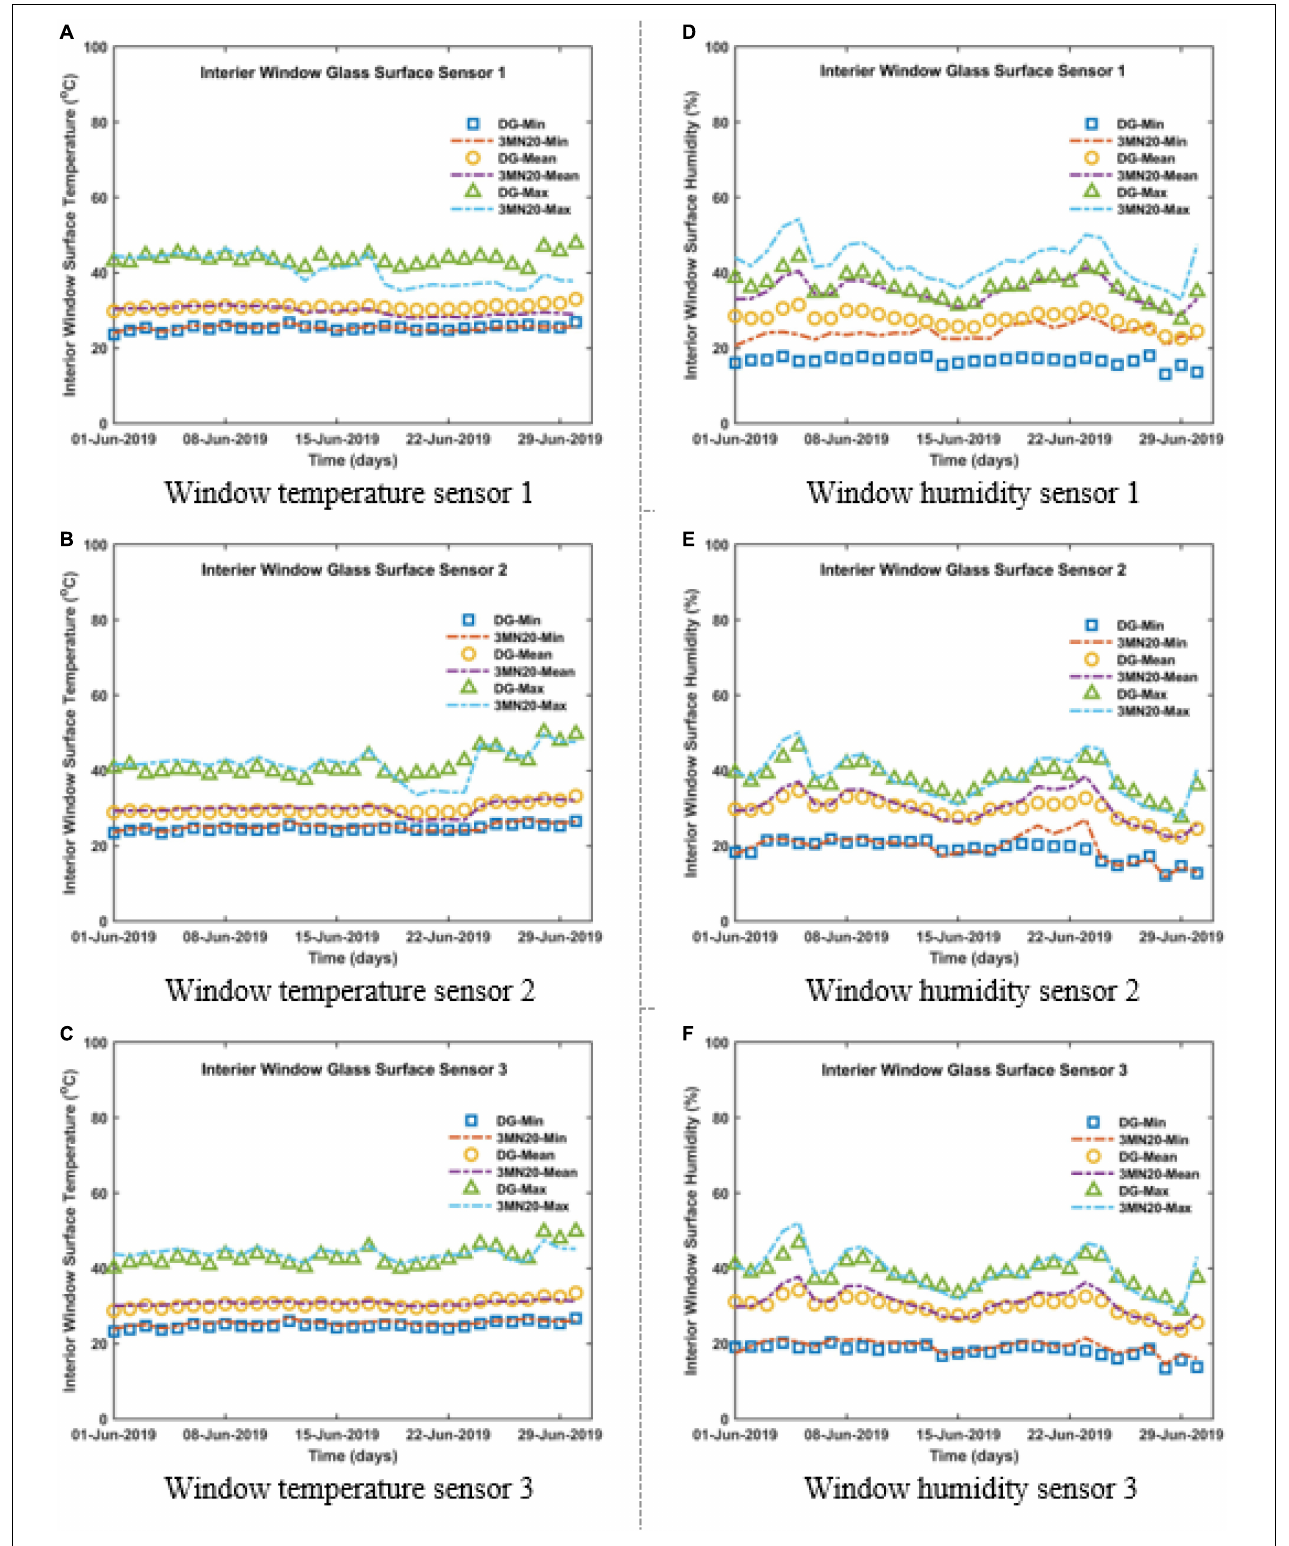
FIGURE 11 | Temperature and humidity (max-mean-min) for three DHT22 sensors on the interior glass surface of the offices with double glazing (DG) and 3M Neutral 20 (3MN20) windows during the month of June 2019; (A–C) temperatures, and (D–F) humidity variations.